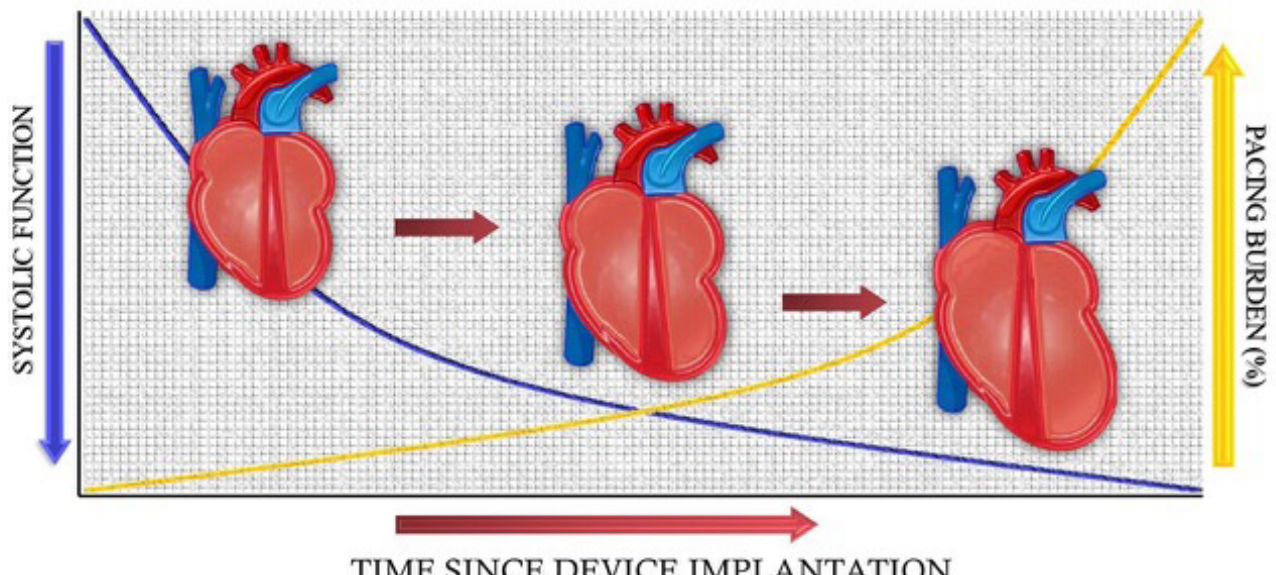
Fig. 1 - Cardiomyopathy induced by artificial cardiac pacing: pathophysiological evolution of artificially induced myocardial ventricular